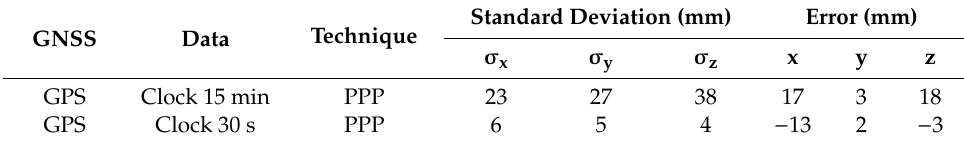
Table 5. Standard deviations and errors of GPS-PPP (Precise Point Positioning) with 15 min clock data and GPS-PPP with 30 s clock data. Estimate ZTD tropospheric model and outlier rejection strategy are